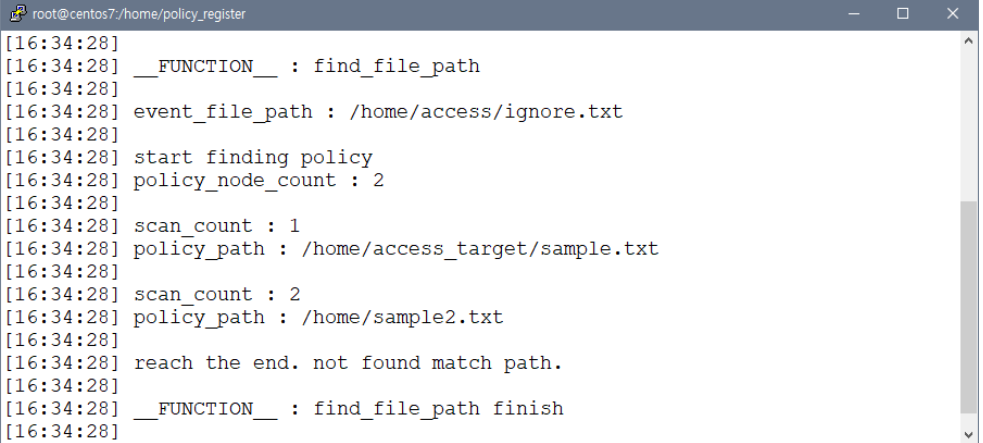
Figure 9. File access event parser ignoring function verification. When user file access does not match any monitoring policies, the file access event parser ignores the user file access